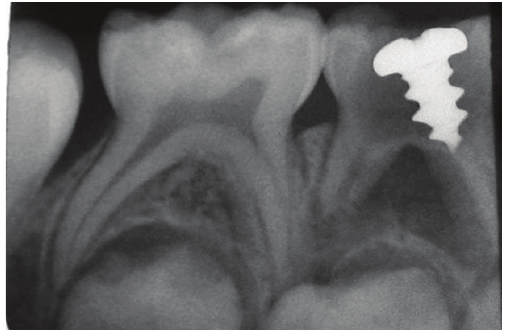
Figure 3: IOPA after retrieval of the metallic screw.